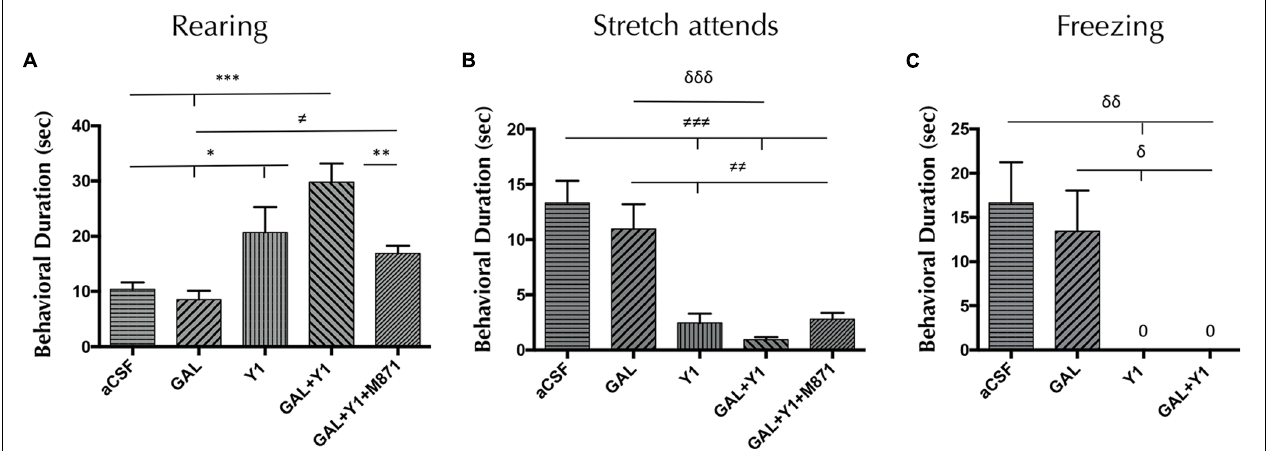
FIGURE 1 | Open field behavioral analysis mediated by Galanin (GAL) and the Neuropeptide Y Y1 receptor (NPYY1R) agonist. The response induced by GAL on the NPYY1-mediated ethological behaviors is blocked by the GAL receptor 2 (GALR2) antagonist M871. Cumulative behavioral duration of rearings (A) , stretch attends postures (SAP) (B) and freezing (C) in the open field. Data represent mean ± SEM. N = 6–8 animals in each group. Value for GAL+Y1+M871 group on freezing was 0.07 ± 0.06. ∗ P < 0.05; ∗∗ P < 0.01; ∗∗∗ P < 0.001; (cid:54)= P < 0.05; (cid:54)=(cid:54)= P < 0.01; (cid:54)=(cid:54)=(cid:54)= P < 0.001; δ P < 0.05; δδ P < 0.01; δδδ P < 0.001 according to one-way ANOVA followed by Newman–Keuls Multiple Comparison Test. Inter-group comparisons are indicated by the lines above bars. GAL, Galanin 3 nmol; Y1 = NPY receptors agonist [Leu 31 -Pro 34 ]NPY 3 nmol; GAL+Y1, Coadministration of GAL and Y1; GAL+Y1+M871, Coadministration of GAL, Y1 and GALR2 antagonist M871 3 nmol.